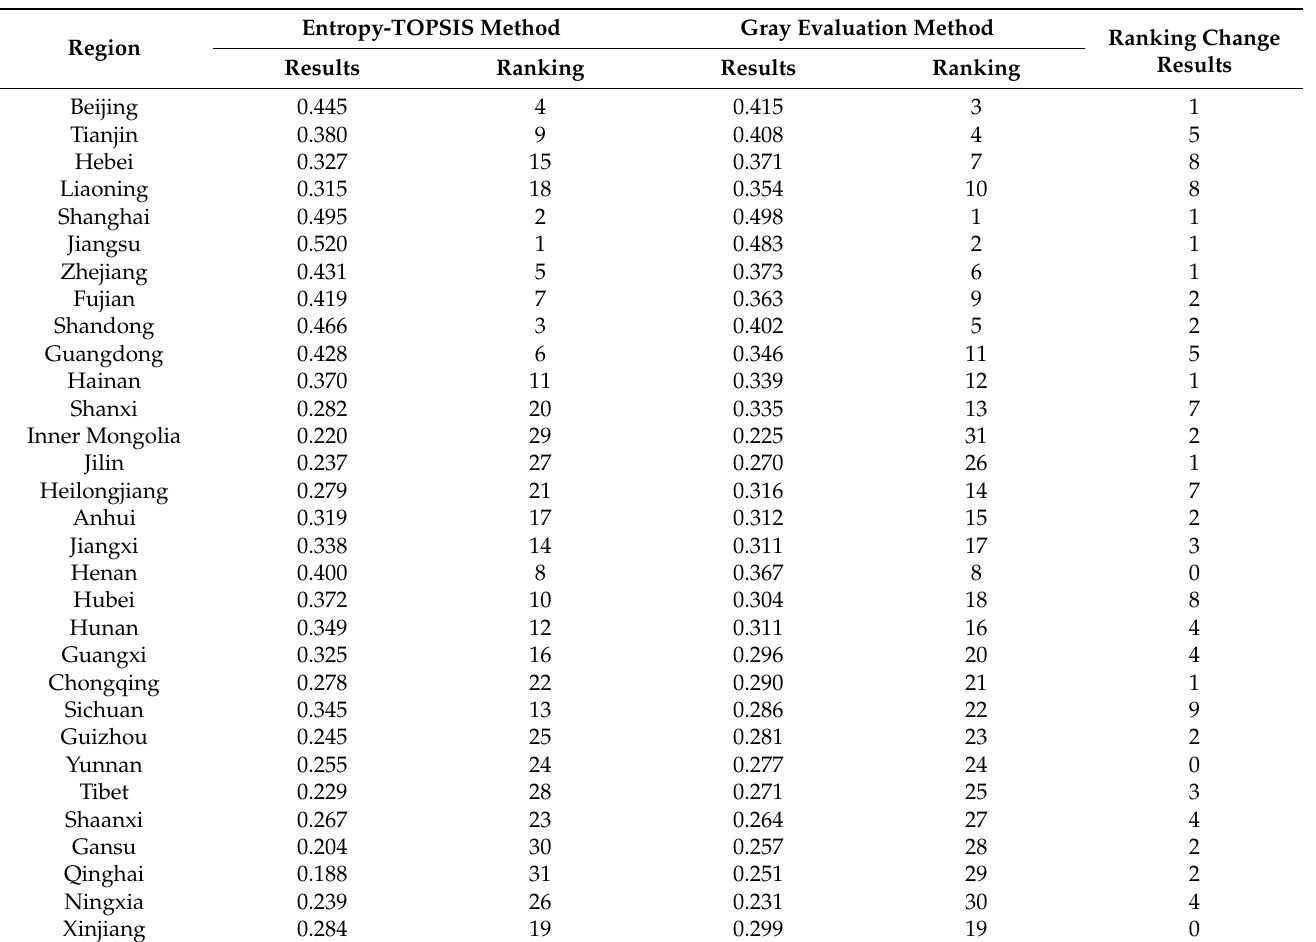
Table 3. Ranking and comparison of evaluation levels of rural